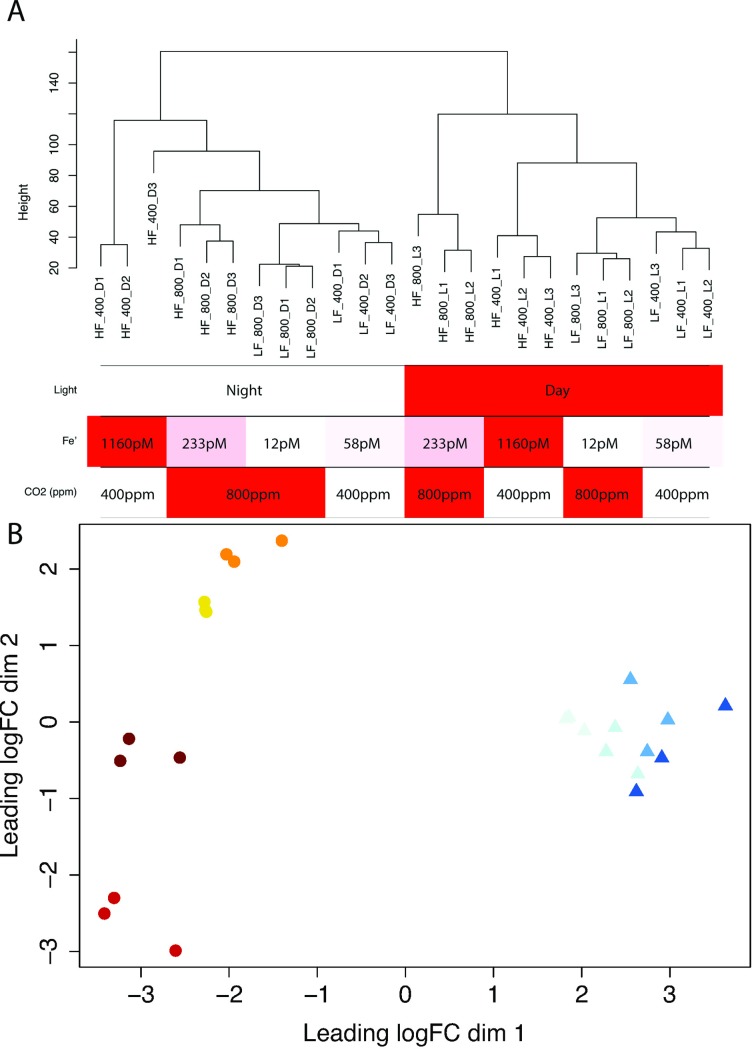
Dendrogram representing the hierarchical clustering (A) or multidimensional scaling (MDS) (B) of the transcriptome profiles. (A) Height in the dendrogram reflects both the order the clusters were joined and the distance between them. HF = high Fe, LF = low Fe, 400 and 800 designate the CO2 levels (in ppm). L and D indicates samples taken in the light (L) or in the dark (D). Red shades in table indicate Fe’ concentration (darker at 1160 pM to lighter at 12 pM), CO2 (red = 800 ppm; no color = 400 ppm) and sampling time (red = midday; no color = midnight). (B) Distances between samples indicate the leading log2-fold-change or the root-mean-square log2-fold-change between the samples for the top 500 genes that distinguish those samples, in two-dimensional space (dim 1 and dim 2). Circles represent light samples from the highest Fe’ (dark red) to the lowest Fe’ (yellow). Triangles represent dark samples from the highest Fe’ (dark blue) to the lowest Fe’ (light blue).